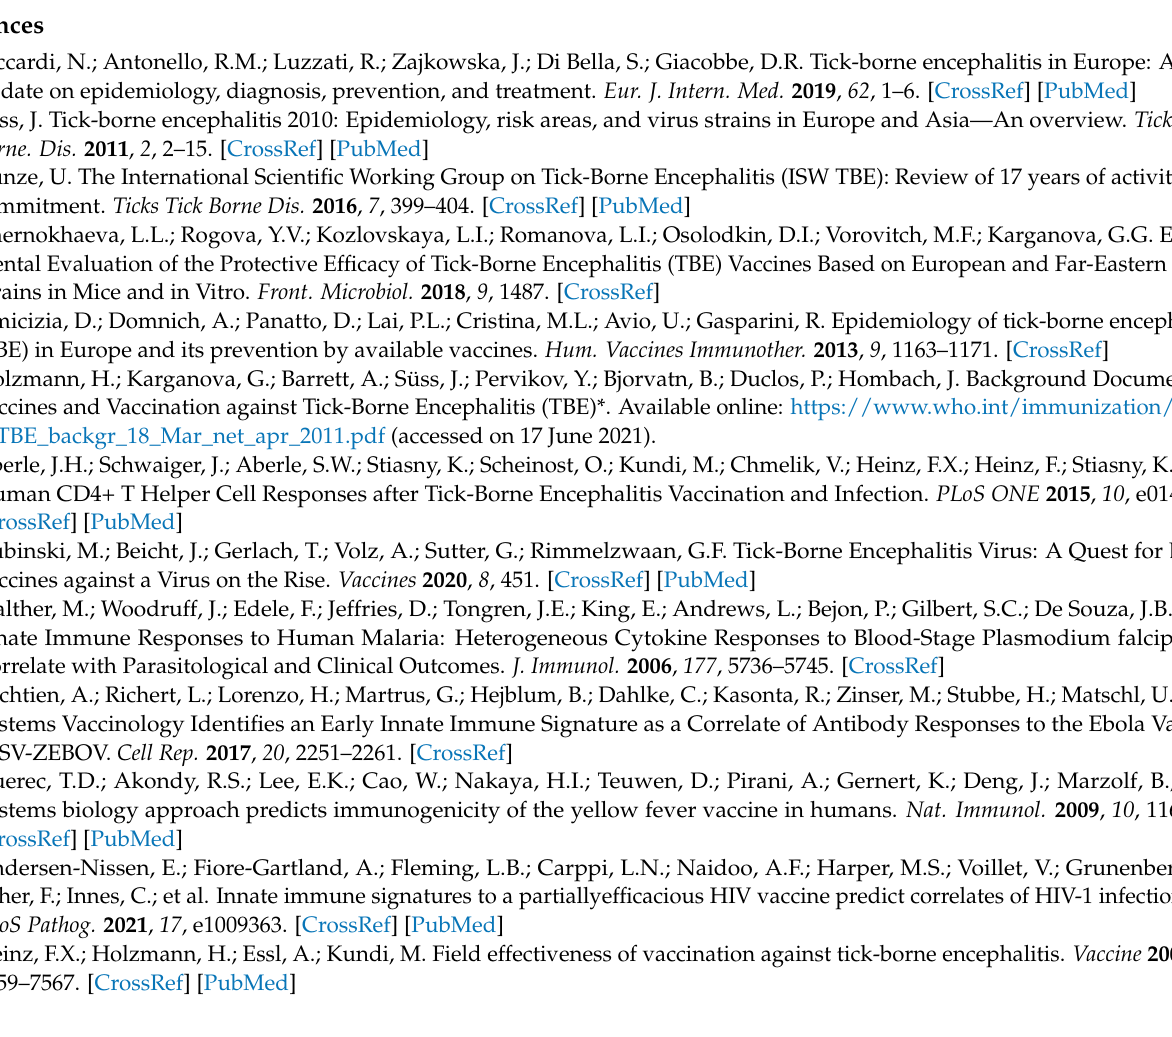
Figure A9. Upregulation of ISG56 in PBMCs incubated with RLR inhibitors. PBMCs from 3 healthy donors were pre-incubated with RLR inhibitors (ALX at 50 µ g/mL and BX at 2 µ M) for 1 h. Afterwards, the cells were treated for 24 h with I-TBEV (0.24 µ g/mL), or left untreated. Following stimulation, the cells were lysed and changes in gene expression were analyzed by